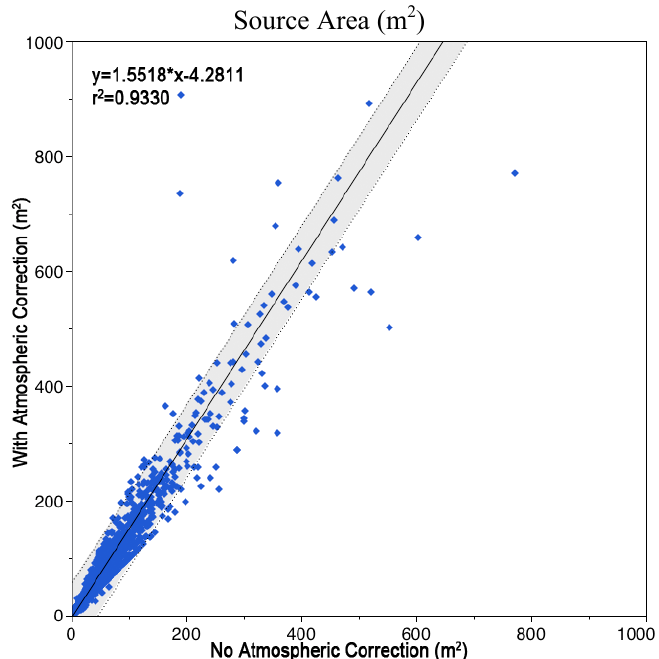
Figure 12. Plot of local maxima source area estimates with and without atmospheric correction from 4 April 2013. The shaded area encompasses the 99% confidence interval around the regression